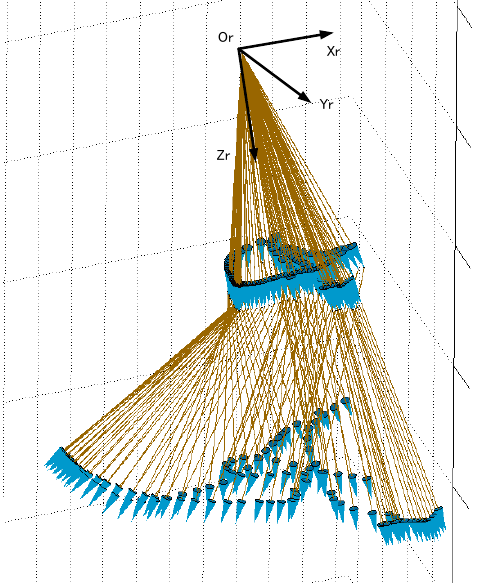
Fig.8 One gait circle shown by continuous stick figures to estimate the human gait posture. The blue arrows represent the knee joint and ankle